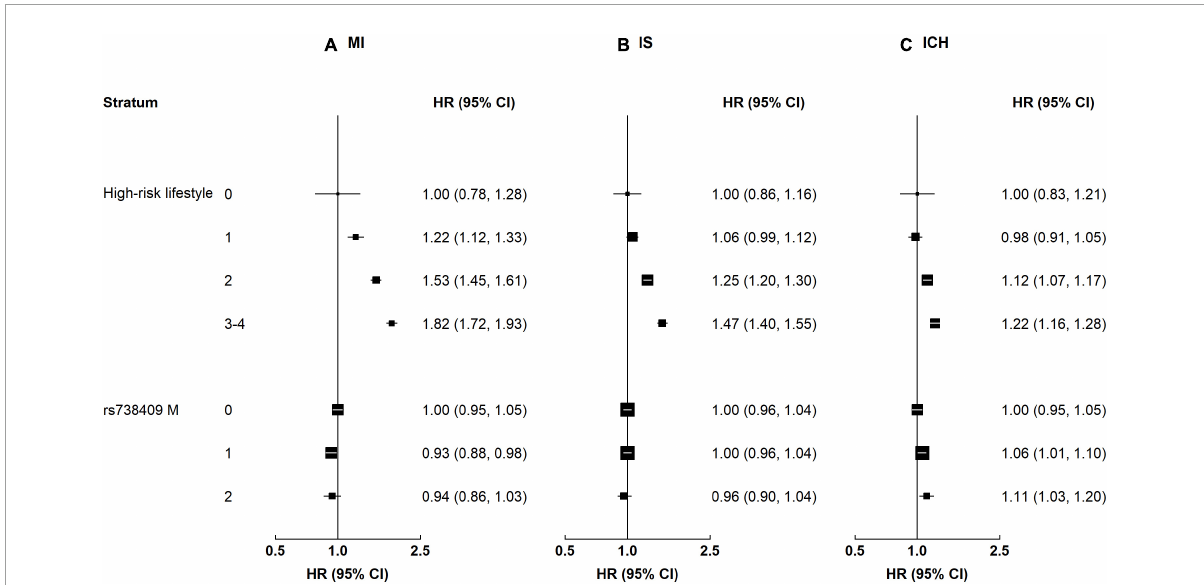
FIGURE2 Associations of high-risk lifestyle and genetic risk factors with risk of CVD. Columns (A–C) denote the results for MI, IS, and ICH, respectively. Convention as in Figure 1 .